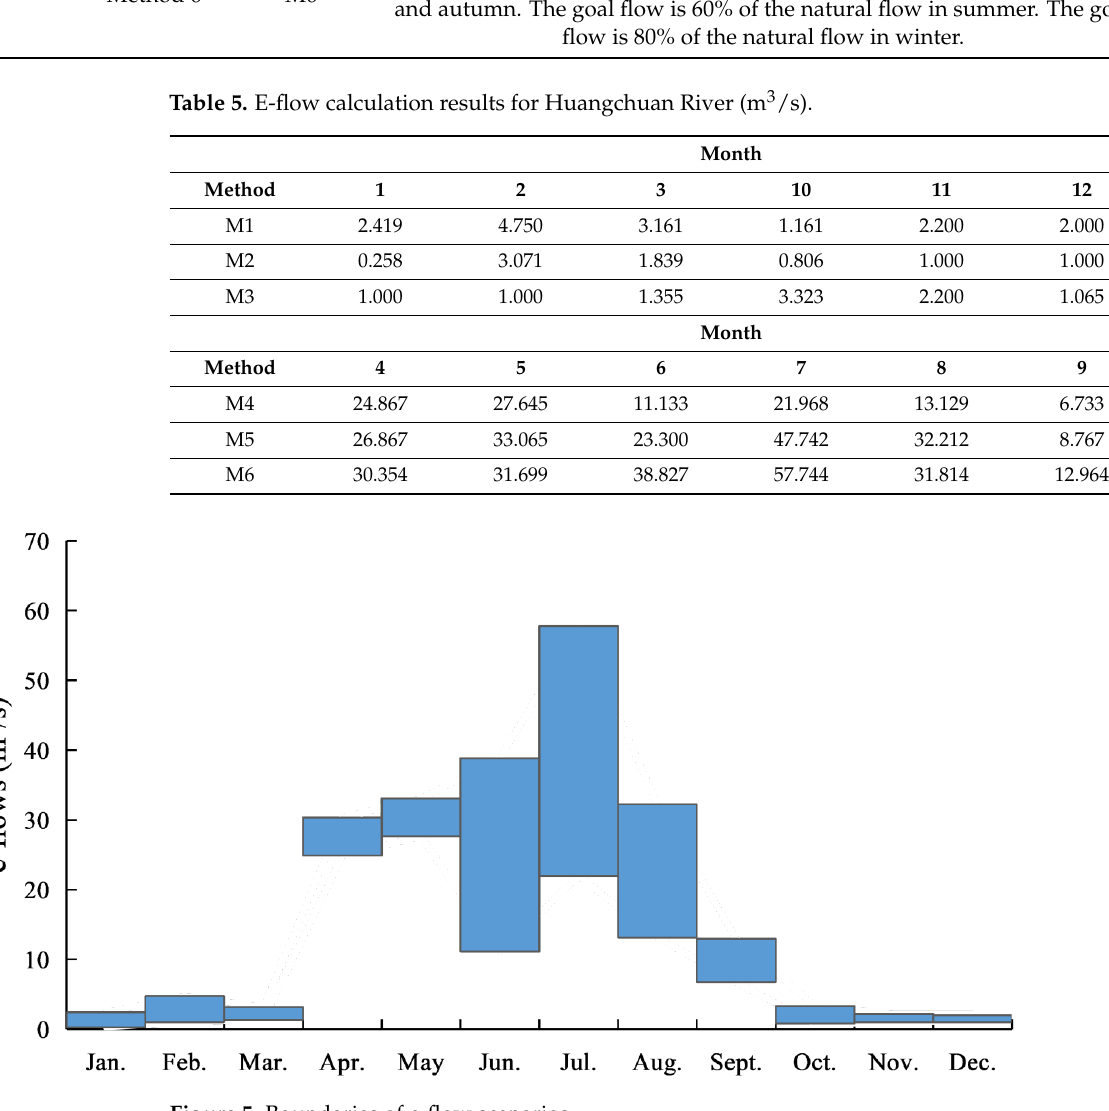
Figure 5. Boundaries of e-flow scenarios.